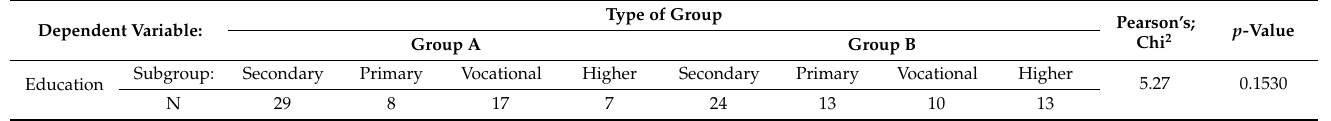
Table 2. Baseline characteristics for both